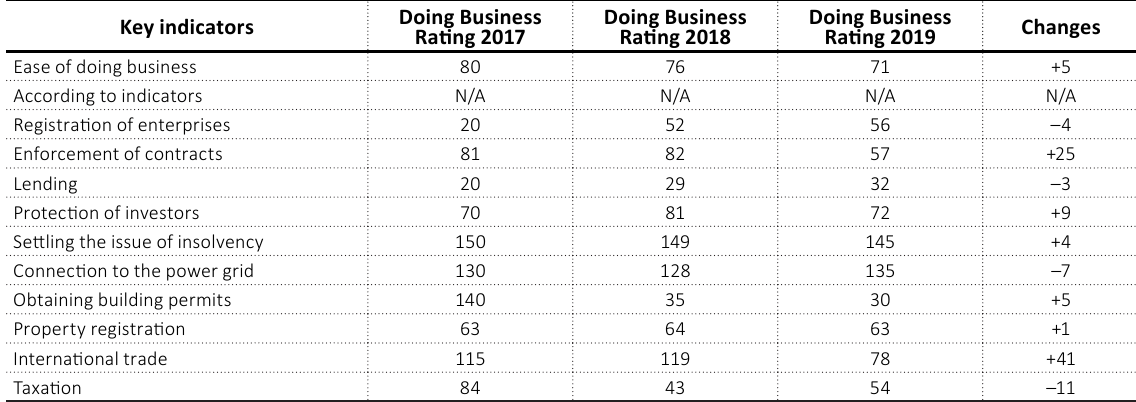
Table 4. Key indicators of Ukraine in the Doing Business Rating in 2018–2019 Source: Formed based on the data from State Statistics Service of